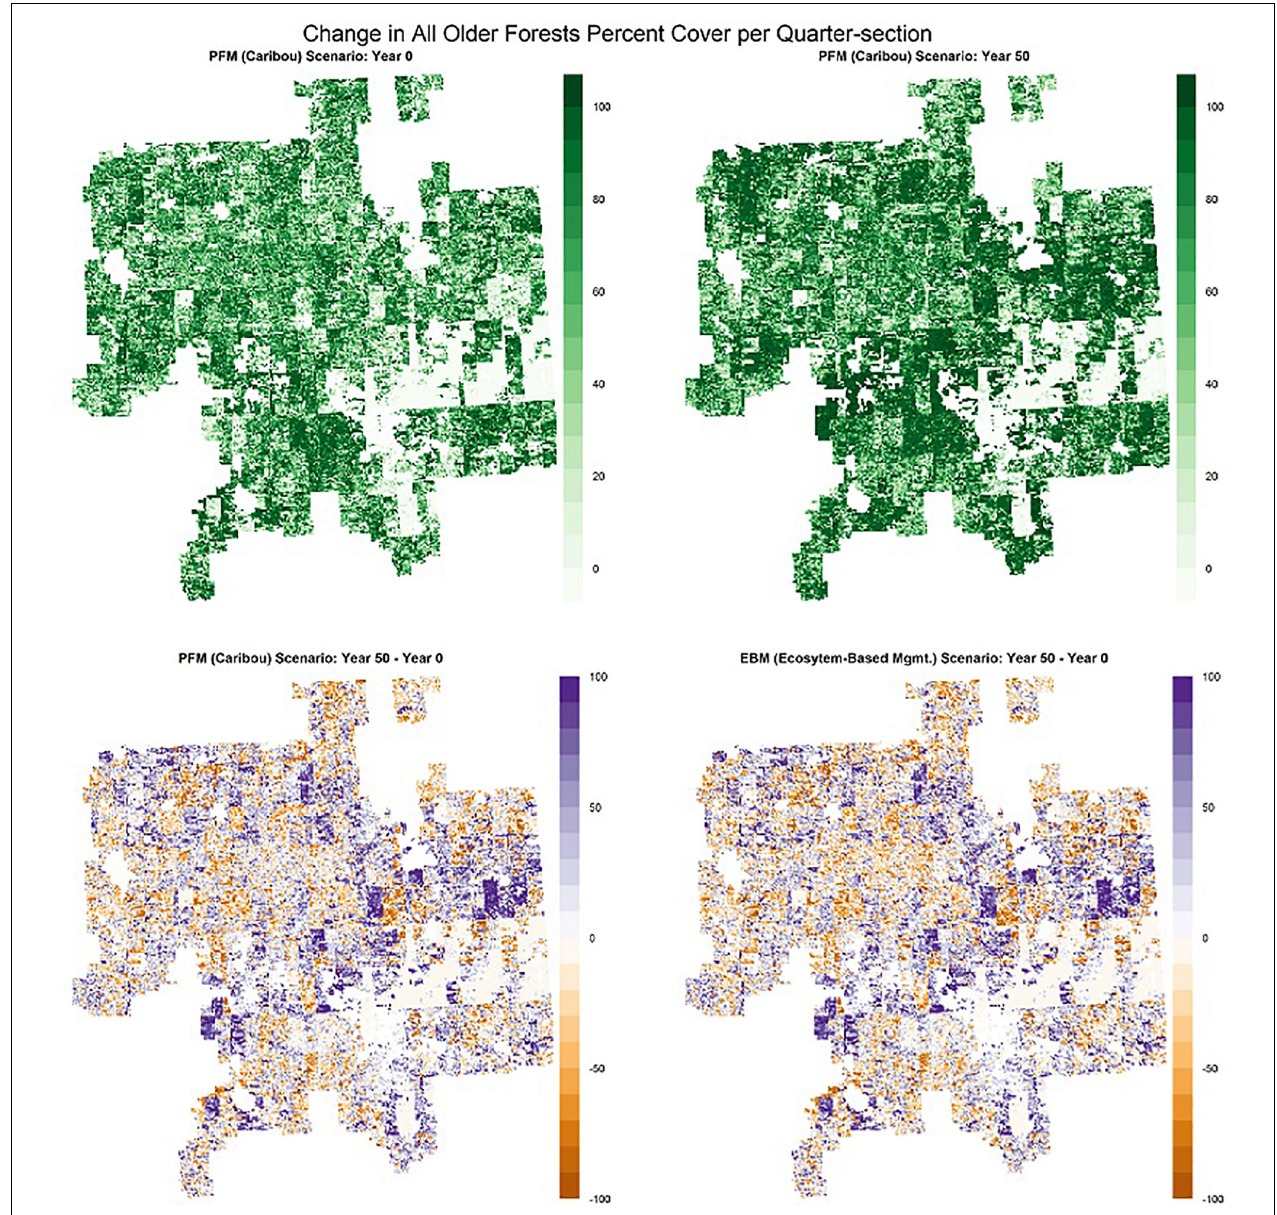
FIGURE 7 | Distribution of all older forests (deciduous and mixed-wood forest stands > 60 years old and black spruce, pine, and white-spruce stands > 80 years old, regardless of origin from fires or harvest) in the Al-Pac Forest Management Area (FMA): (1) mean percent cover per quarter-section by all older forests in Year 0 of the Preferred Forest Management (PFM) scenario that included harvest deferral within caribou habitats (top left) ; (2) mean percent cover per quarter-section by all older forests in Year 50 of the PFM scenario (top right) ; (3) change in mean percent cover per quarter-section by all older forests over 50 years under the PFM scenario (bottom left) ; (4) change in mean percent cover per quarter-section by all older forests over 50 years under the Ecosystem-Based Management/Natural Disturbance Model (EBM) scenario without harvest deferral (bottom right) . The increase in percent cover of older forests over time was dominated by increases in older black spruce and